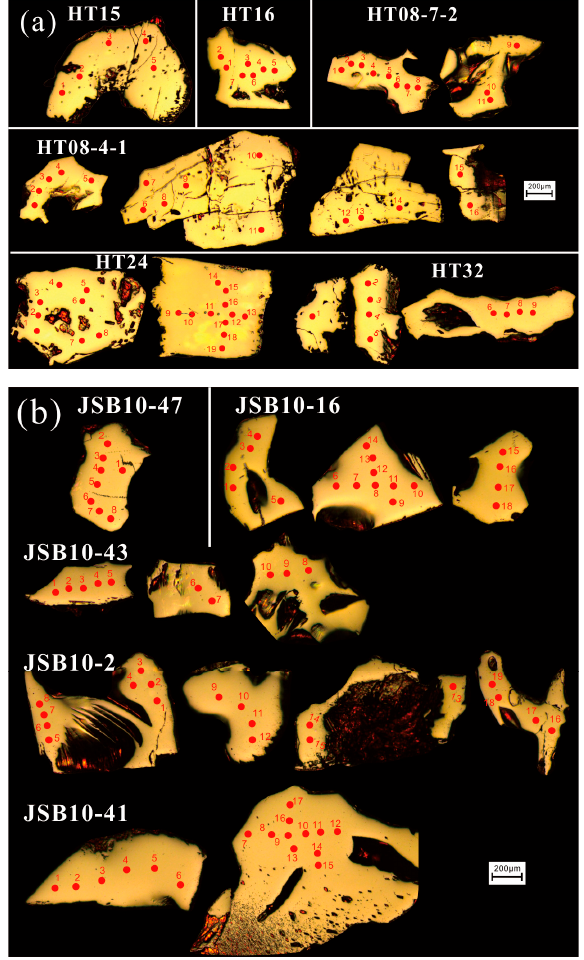
Figure A1. Reflect images of olivine collected from Haoti ( a ) and Hannuoba ( b ) analysis in this study. The red circle indicates the analyzed spot of ion probe analyses.